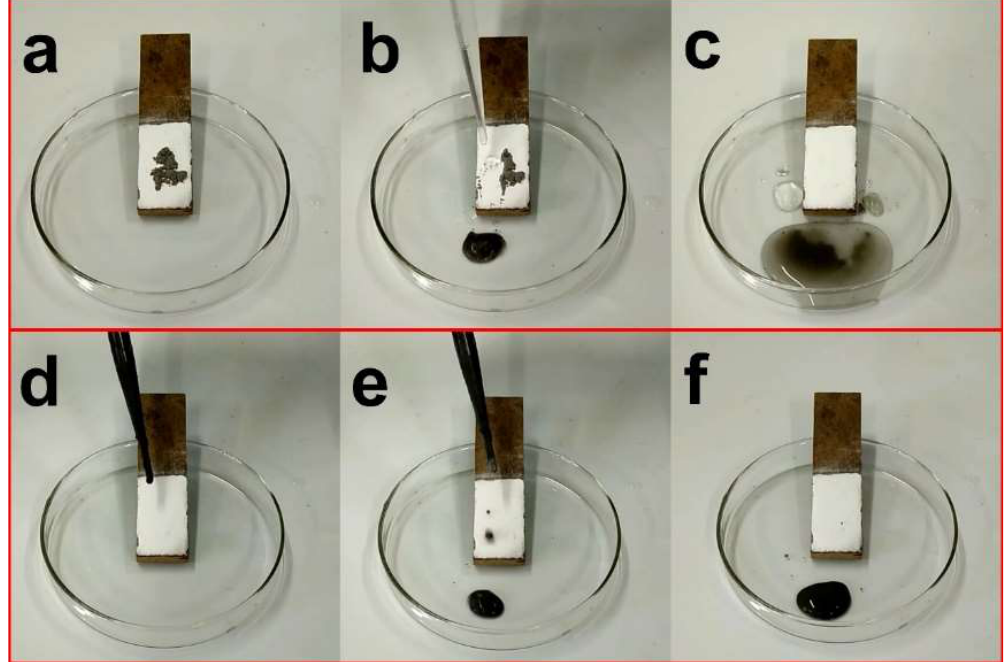
Figure 6. Self-cleaning properties of FDTS-modified Mg/Al LDH coatings. ( a ) Fly ashes on the PDMS@FDTS-Mg/Al LDH coating; ( b ) Fly ashes are taken away by water droplets; ( c ) Clear coating after water droplets washing; ( d ) Original coating before muddy water washing; ( e ) Muddy water roll away from coating; ( f ) Clear coating after muddy water washing.